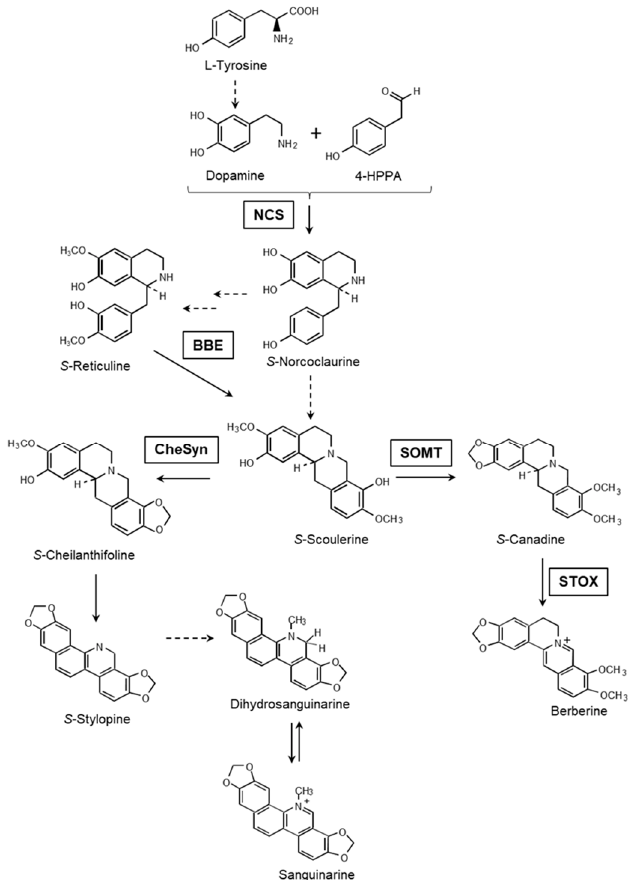
Figure 1. Condensed view of sanguinarine and berberine biosynthesis. The dashed lines represent multiple reactions. NCS , norcoclaurine synthase; BBE , berberine bridge enzyme; SOMT , S ‐ scouler ‐ ine O ‐ methyltransferase; STOX , tetrahydroprotoberberine oxidase; CYP71914 ( ChESYN ), S ‐ chei ‐ lanthifoline synthase.